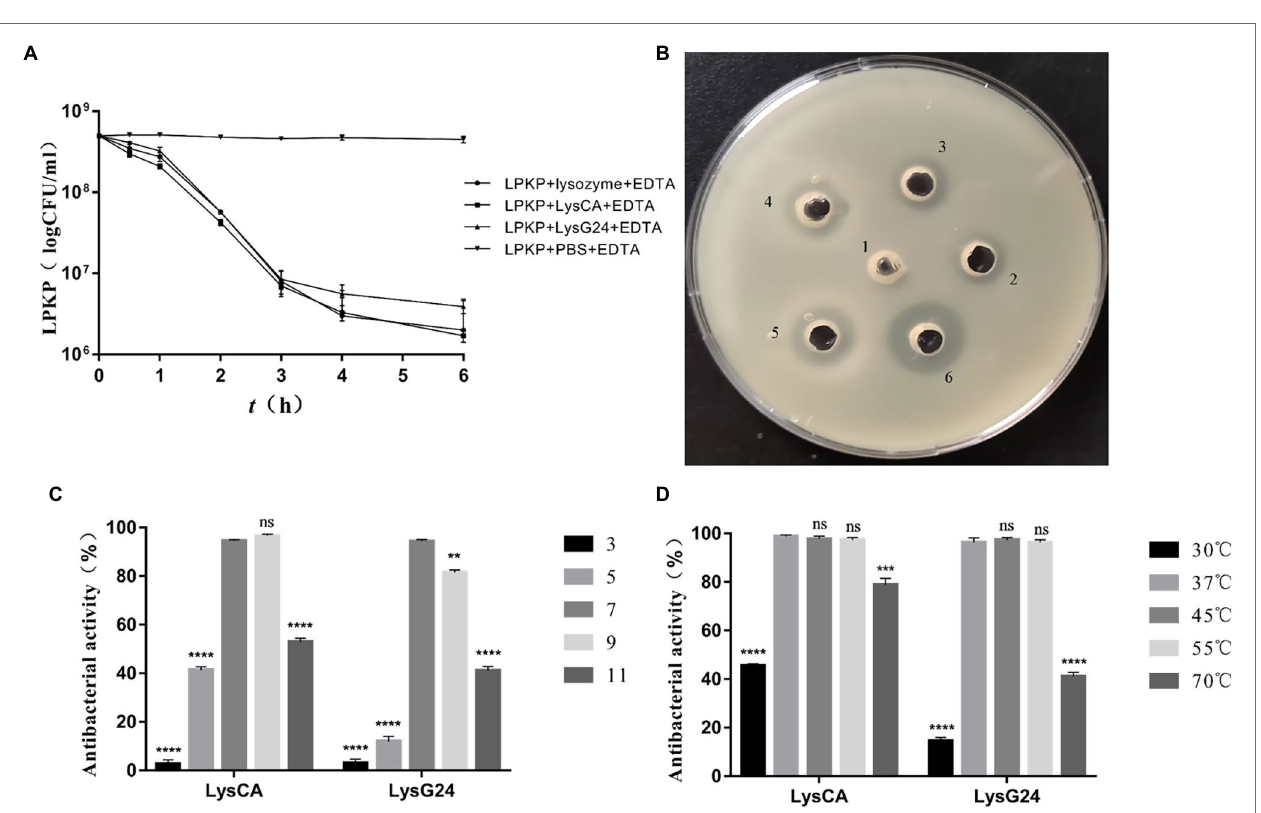
FIGURE 3 | Endolysin LysG24 and LysCA protein expression. Purification results of LysG24 and LysCA recombinant protein. M, Protein molecular weight standard; 1, LysCA unpurified protein; 2, LysCA purified protein; 3, LysG24 unpurified protein; and 4, LysG24 purified